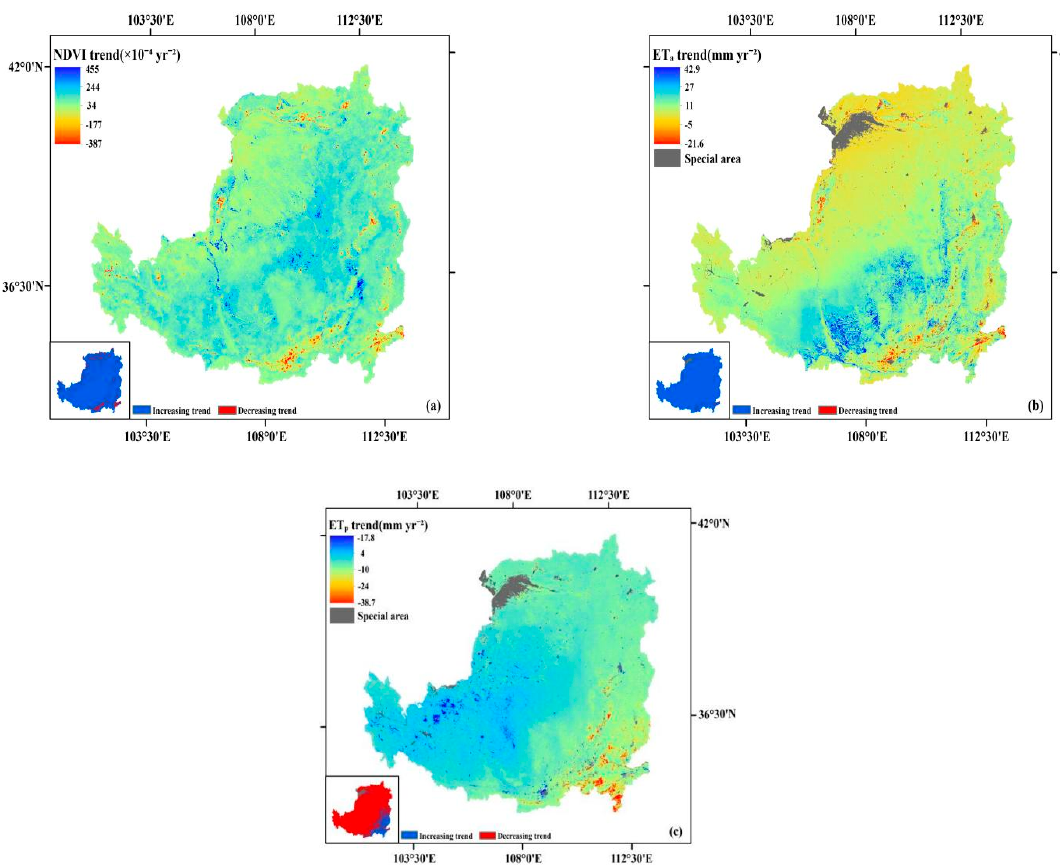
Figure 7. Spatial trends of annual NDVI ( a ), ET a ( b ), and ET p ( c ) in the LP from 2000 to